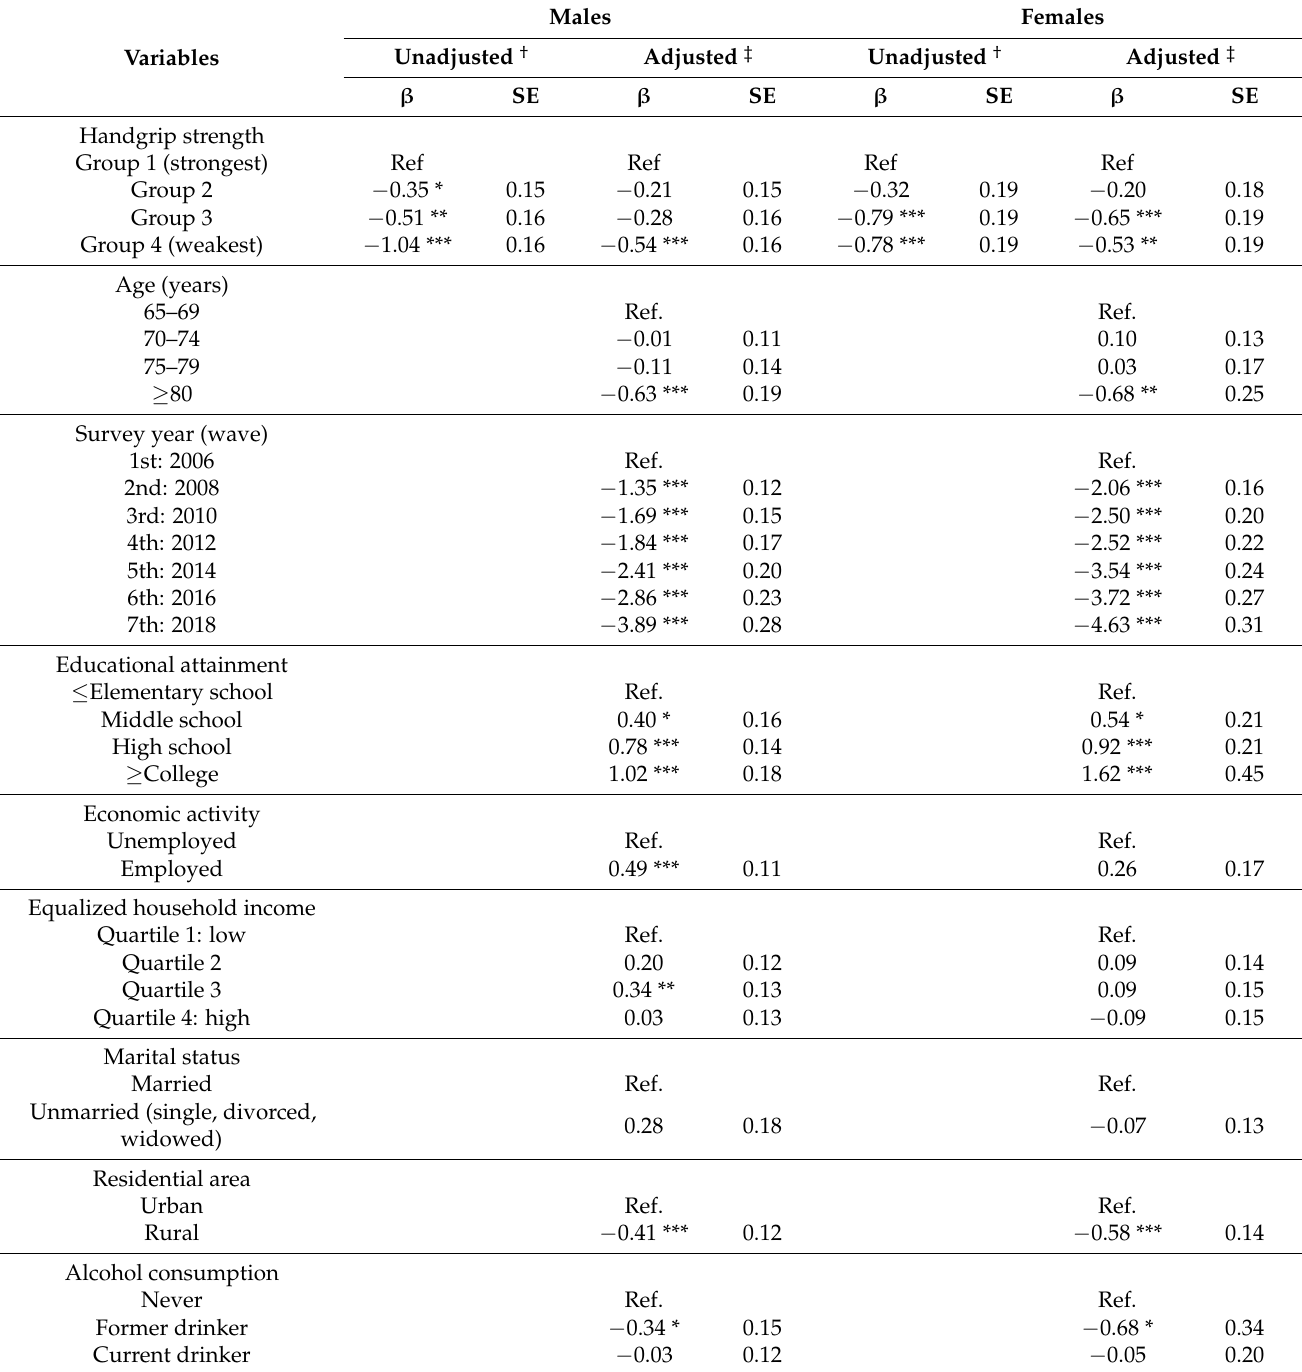
Table 3. Multivariable analysis of factors associated with K-MMSE scores for males and